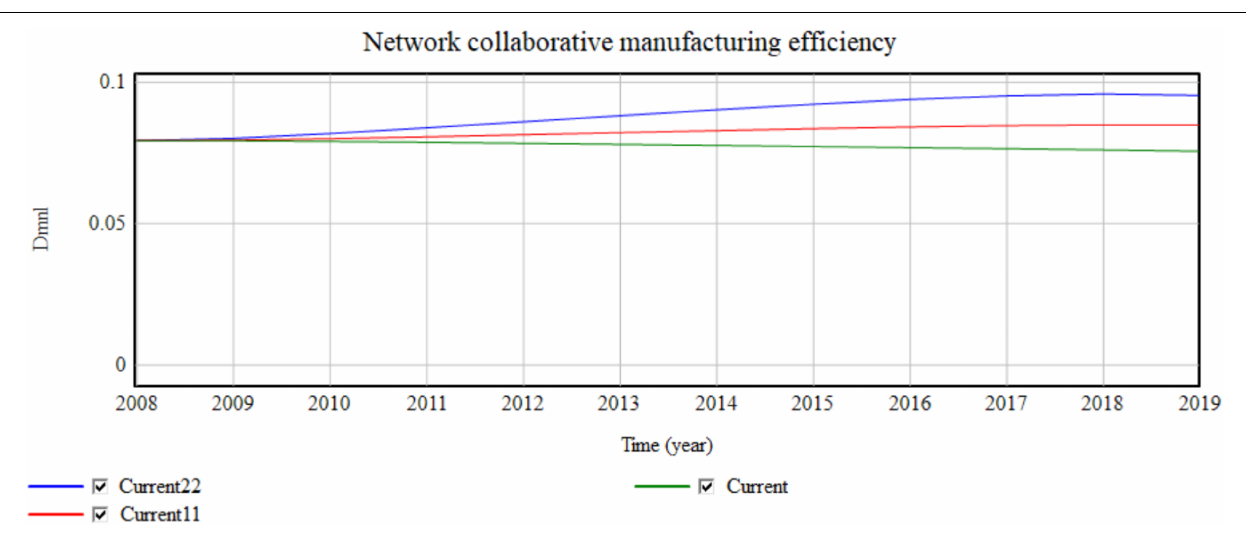
FIGURE 8 | Influence of the micro value network on network collaboration